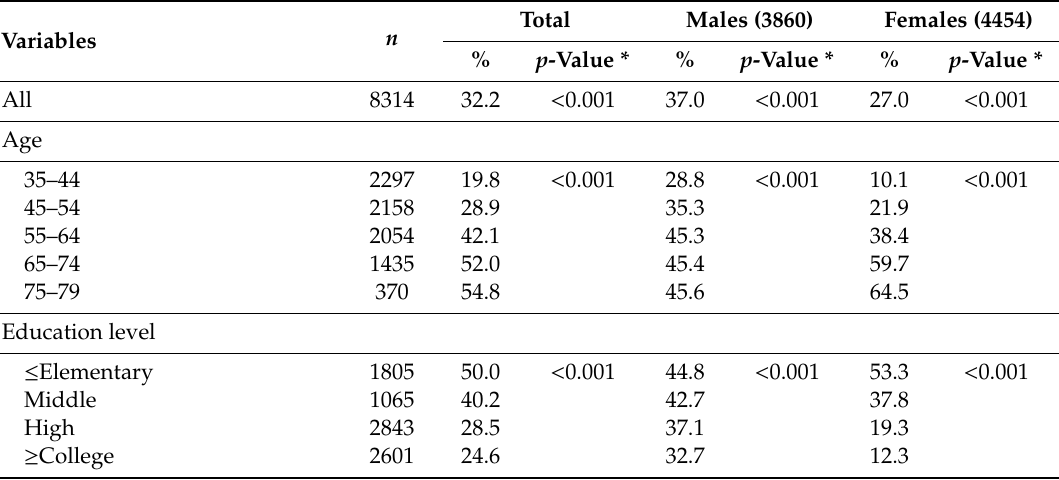
Table 2. The prevalence of MetS according to demographic and socioeconomic status, health behaviors, and periodontitis in total and by